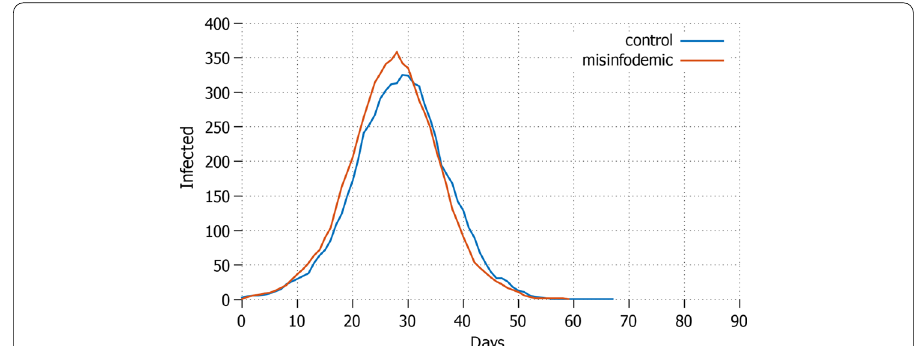
Fig. 9 Retired student, protective measures applied without detection Total cases without detection of infected + with with retired and student in lockdown